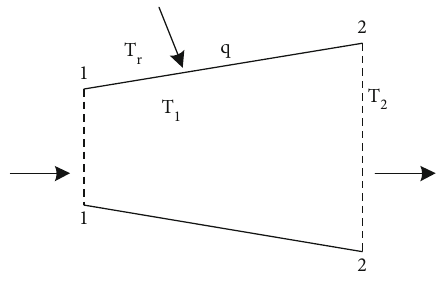
Figure 3: A system with only heat transfer